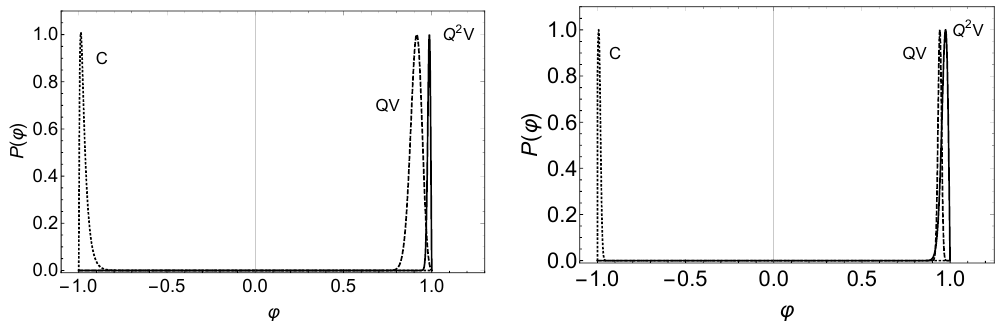
Figure 2 . The asymptotic volume-weighted field distribution for a linear potential with absorbing boundary conditions at ϕ = ± 1 , for fixed α = 10 − 2 (left panel) with β = 10 (C regime), 10 3 (QV regime), 2 × 10 4 (Q 2 V regime), and for fixed β = 10 4 (right panel) with α = 2 . 5 × 10 − 5 (C regime), 10 − 3 (QV regime), 10 − 1 (Q 2 V